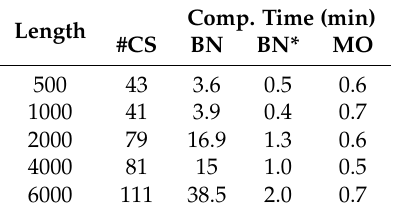
Table 4. BN and MO computation times (in minutes) for the example described in Section 4, for different segment lengths; BN = BN with iterative procedure to find the number of cross sections (#CS); BN* = BN without iterative procedure. Comp. Time (min)